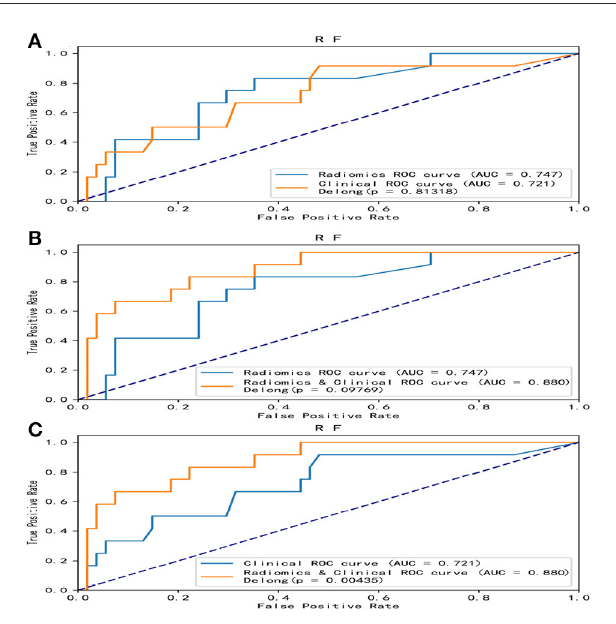
FIGURE6 Comparative analysis of ROC in the random forest model. Among the five models, the random forest model showed the best predictive performance. The random forest model was constructed with radiomics features, clinical features, and combined features, respectively, and the DeLong test was performed. The combined model was significantly better than the clinical model. (A) A DeLong test was used to compare the radiomics model and clinical model. P = 0.813. (B) A DeLong test was used to compare the radiomics model and the combined model. P = 0.098. (C) The DeLong test was used to compare the clinical model and the combined model. P = 0.004. ROC, receiver operating characteristic; RF, random